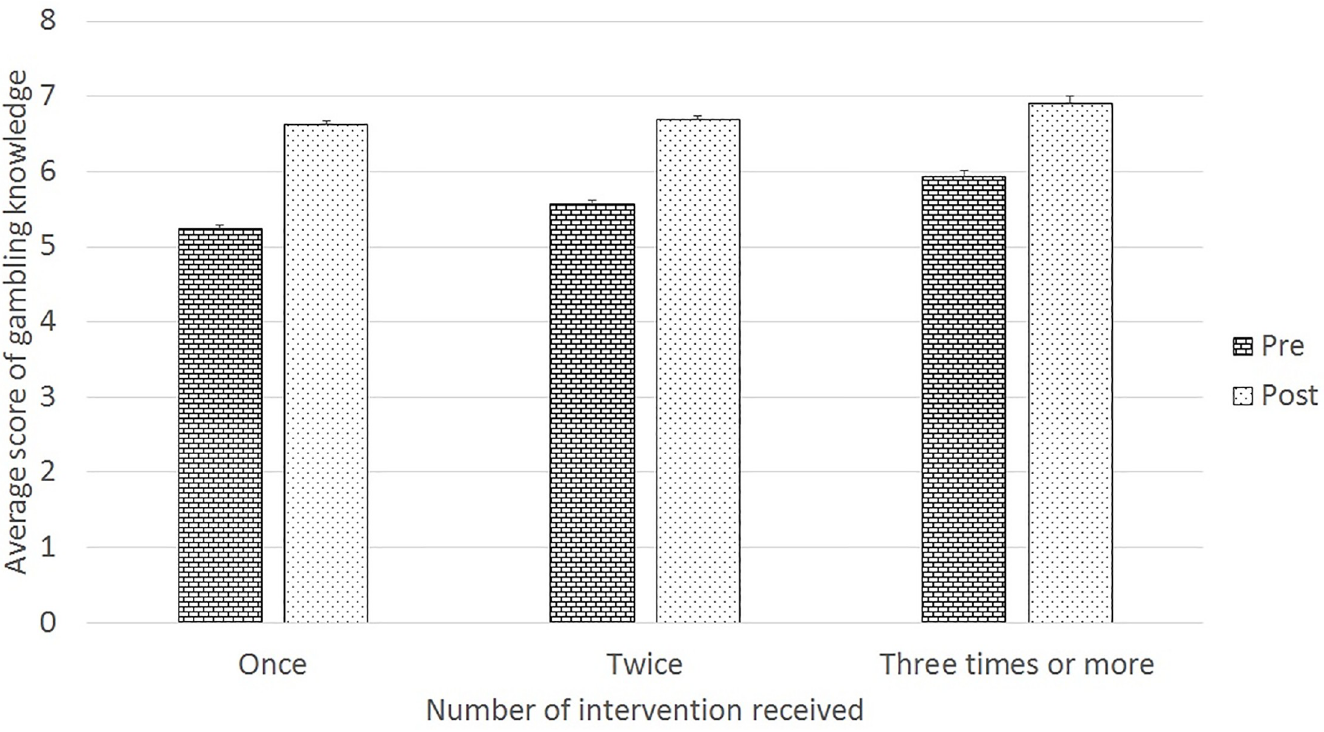
Fig 1. Pre- and post-test scores of gambling knowledge among students receiving single or multiple interventions. � A generalized linear mixed model was used to examine the change of knowledge score between pre- and post-interventions, and compare the scores among students receiving once, twice, and 3+ interventions. P < 0.001 for overall pre- vs post-tests; for pre-test only, P < 0.001 for all comparisons among the tree groups of intervention once, twice, and 3+; for post-test only, P values were 0.007, < 0.001, and 0.128 for intervention twice vs. once, 3+ vs. once, and 3+ vs. twice, respectively. The bars and upper caps stand for means and upper limits of confidence